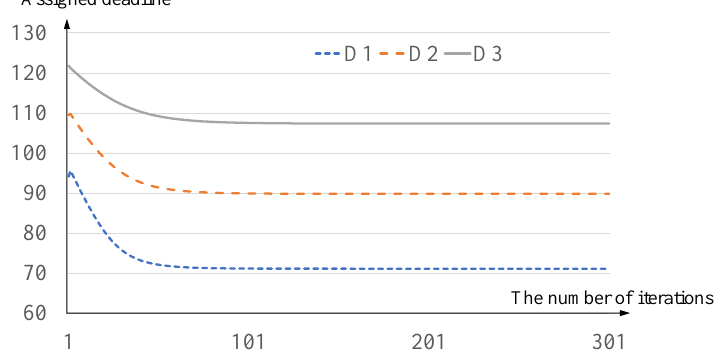
Figure 3. The convergence of the assigned end-to-end deadline for τ 1 , τ 2 and τ 3 (i.e., D 1 , D 2 and D 3